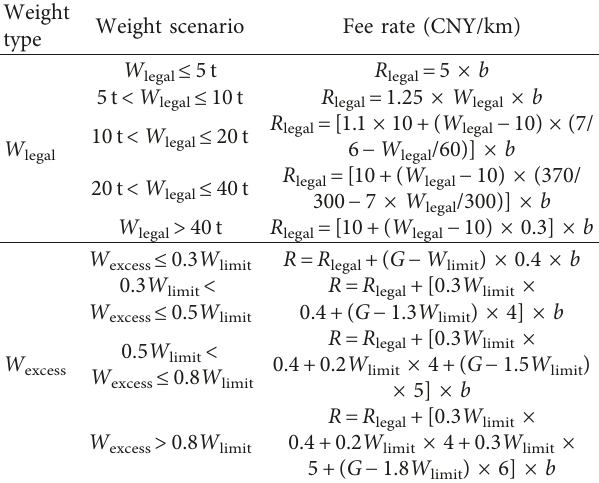
Table 4: Toll fee structure for the revised toll-by-weight policy. Weight Weight scenario type